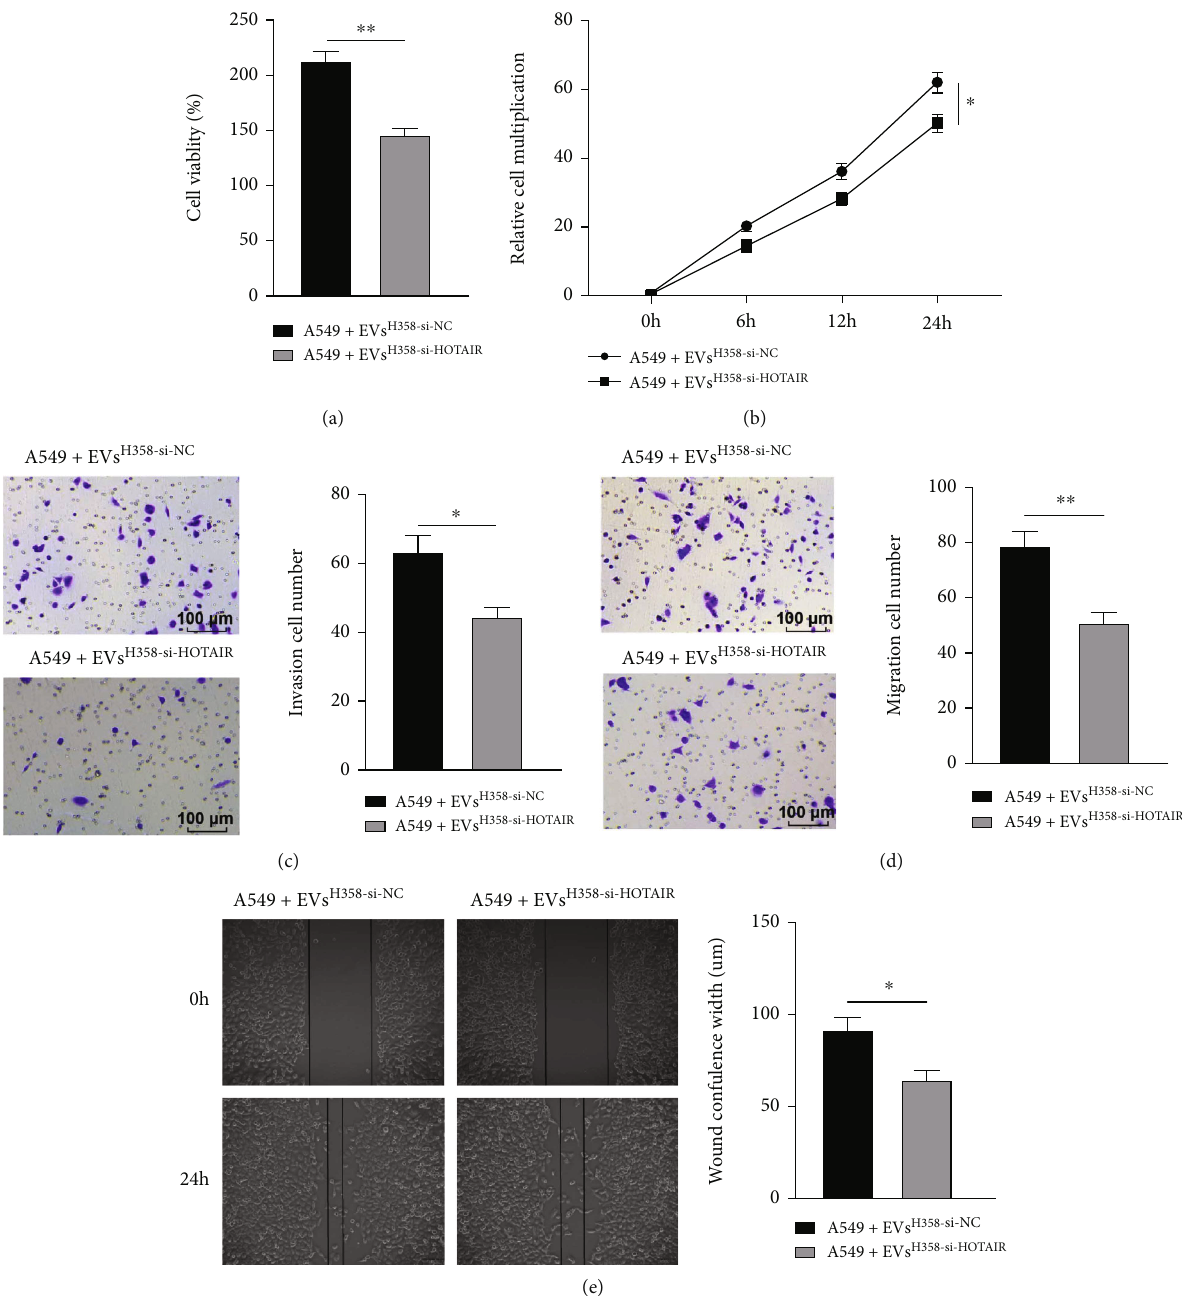
Figure 5: Inhibition of HOTAIR partially reversed the promotion of H358-EVs-mediated CAFs activation on invasion and migration of LC cells. A549 cells were cultured in NFCM treated with H358-EVs-si-HOTAIR for 24 hours. (a) Cell viability was detected by MTT; (b) cell proliferation was detected by CCK-8; (c, d) transwell assay was used to detect cell invasion and migration; (e) cell migration was detected by scratch test. Cell experiment was repeated three times. Repeated measures ANOVA was used for data comparison between groups in Figure (b), and t -test was used for data comparison between groups in Figures (a), (c), (d), and (e). ∗∗ P < 0 : 01